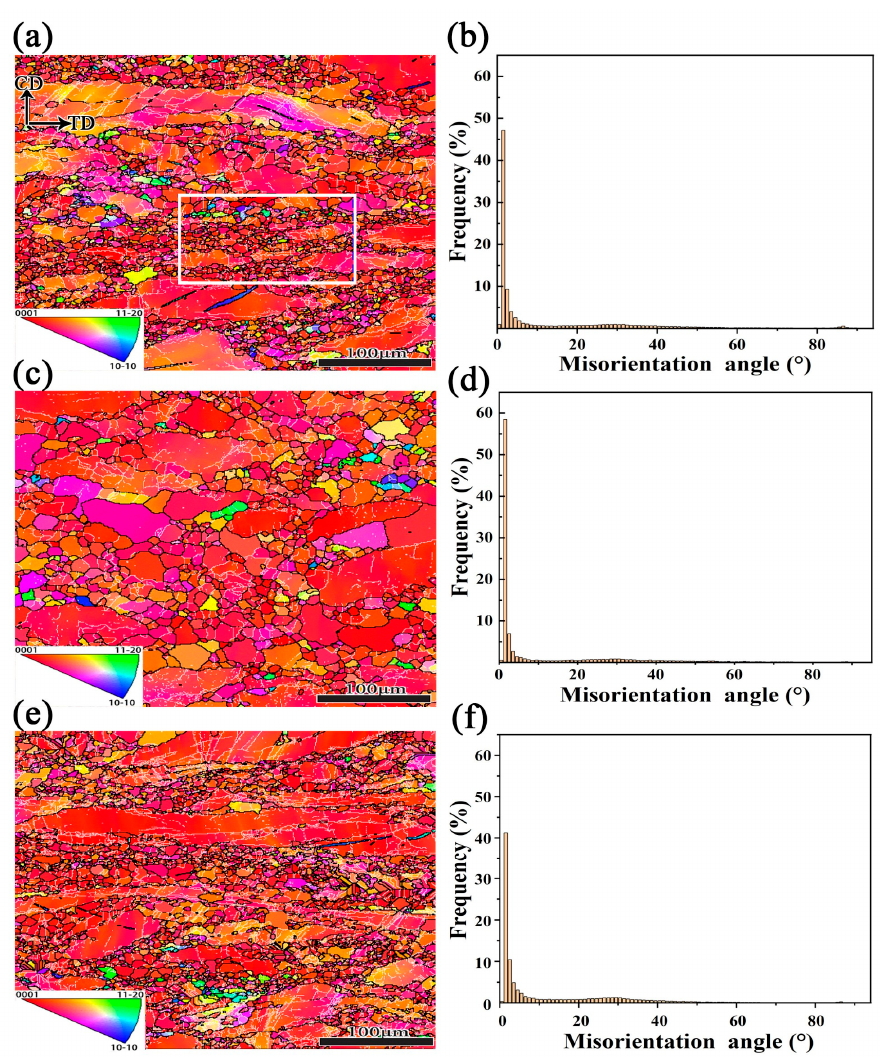
Figure 14. Inverse pole figures and misorientation angle distribution maps of Mg-3Bi alloy under specific conditions ( a , b ) 573 K and 0.01 s − 1 , ( c , d ) 623 K and 0.01 s − 1 , ( e , f ) 573 K and 0.1 s − 1 , respec- tively.